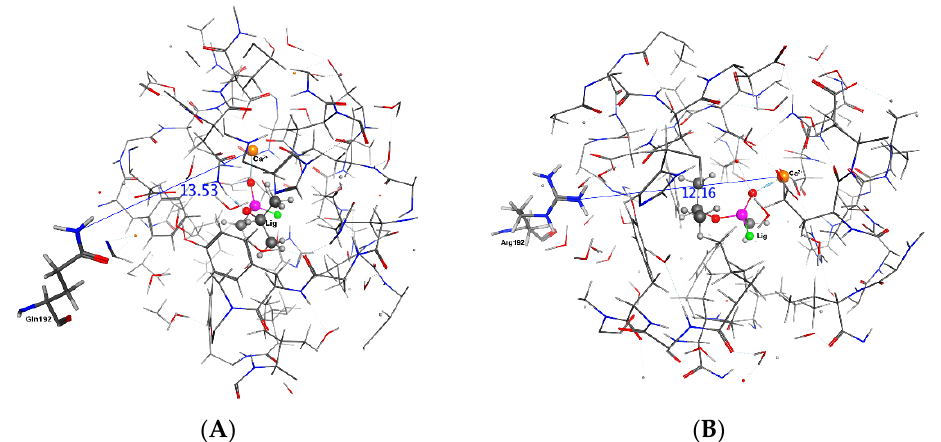
Figure 8. The distance between Glu192/Arg192 and Ca 2+ ion in the active site in the Sarine–Enzyme complex after 20 ns. ( A ) QPON1. ( B )